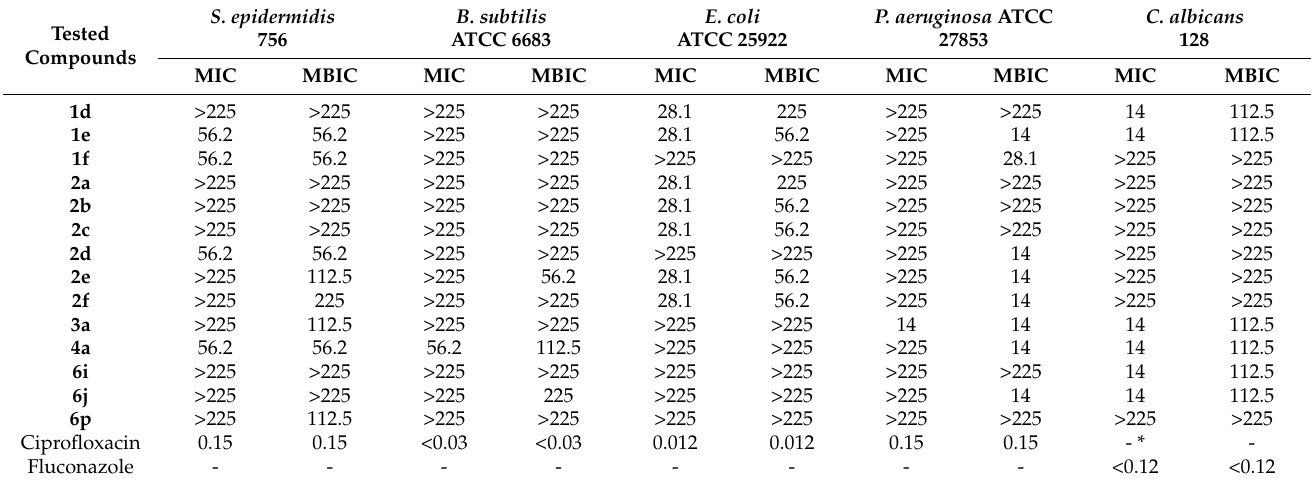
Table 2. The MIC and MBIC values ( µ g/mL) measured for compounds 1d–f ; 2a–f ; 3a ; 4a ; 6i,j ; and 6p against the tested microbial